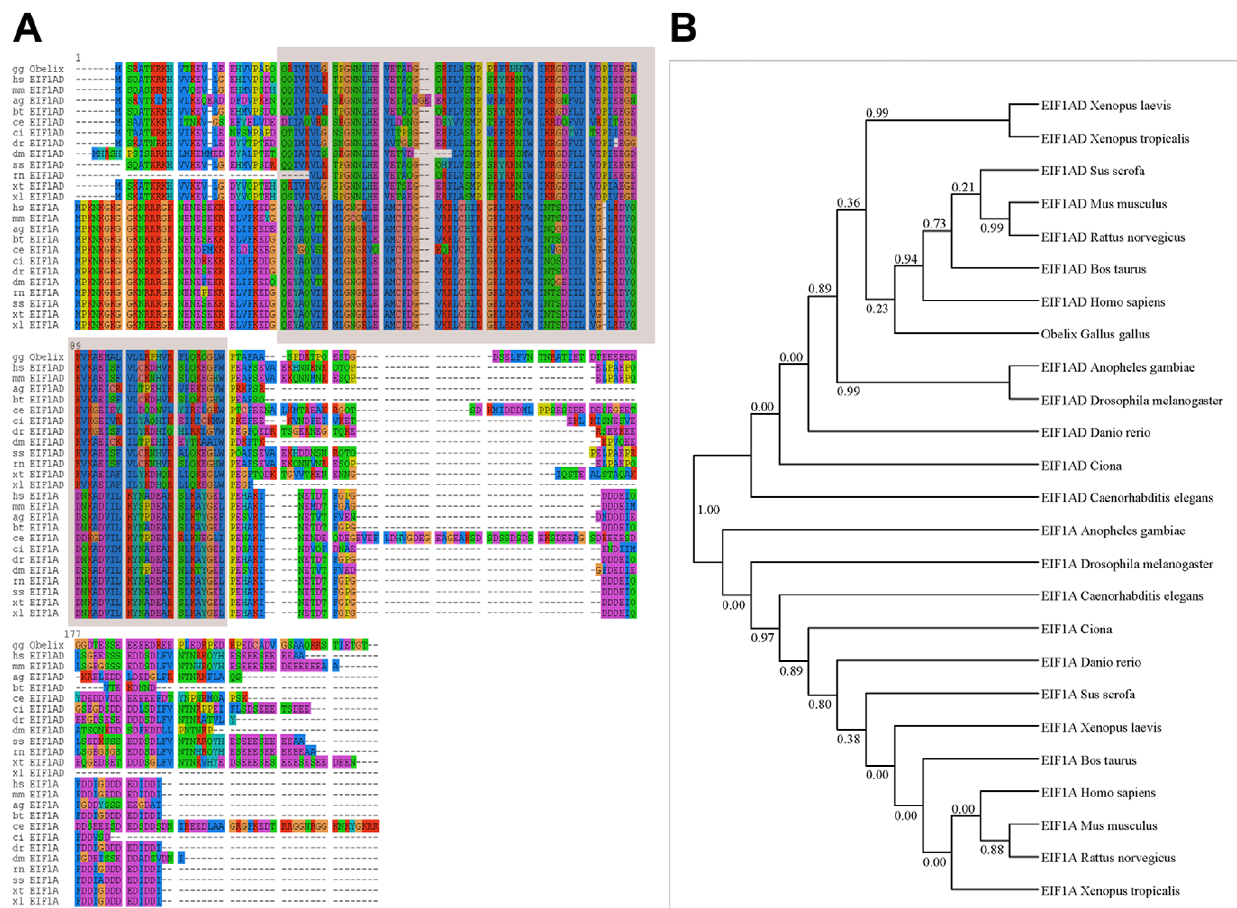
Figure 1. Molecular characterization of Obelix . A. Sequence alignment of Obelix protein (AY103477) with ESTs for EIF1A-related proteins from several species. Residues are displayed in different colours based on different aminoacid families and degree of homology is represented by conservation of these sites. Conserved OB-like domain is shown as a block in the alignment. Species are abbreviated as follows: ag, Anopheles mosquito (BM594550); bt, cow (BF043073); ce, C. elegans (AV203381); ci, Ciona (AV841463); dm, Drosophila melanogaster (BE977318); dr, zebrafish (BM859434); hs, human (BG149615); mm, mouse (BI103120); ss, pig (BG610103); rn, rat (BF420639); xl, Xenopus laevis (BG730245); xt, Xenopus tropicalis (AL637659). B. Phylogenetic tree with bootstrap values comparing the full-length sequences of Obelix in a variety of species, showing that eIF1A and Obelix segregate into two distinct sub-classes of OB-containing proteins. The LG model was used to construct the tree and bootstrap values were calculated from 1000 replicates.